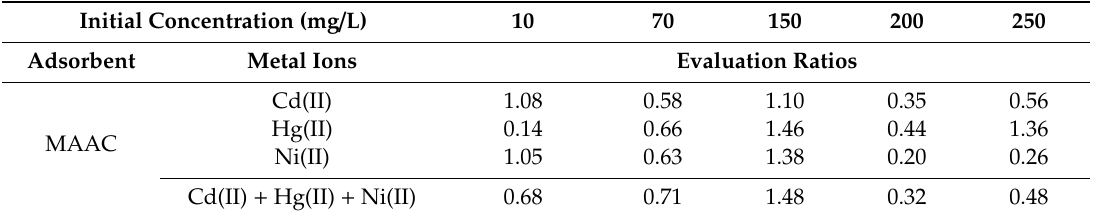
Table 2. Individual and sum of the evaluation ratios of Cd(II), Hg(II) and Ni(II) in the ternary system for MAAC beads. Initial Concentration (mg / L) Adsorbent Metal Ions Evaluation